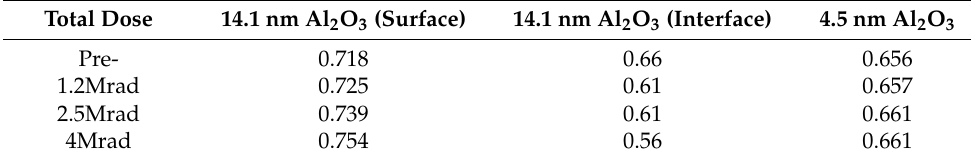
Table 1. Atomic concentration ratio between Al and O in the Al 2 O 3 /Si structure. Total